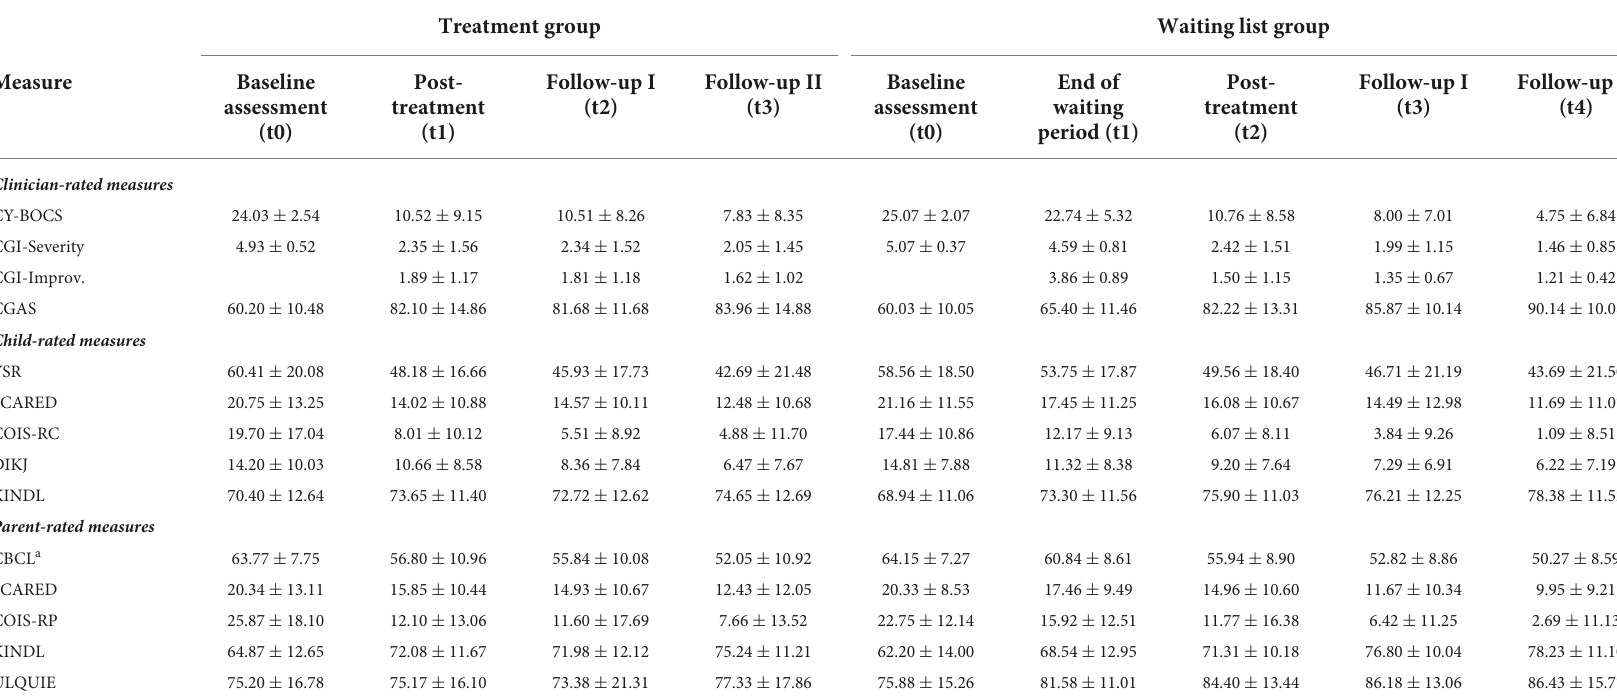
Unadjusted mean ± standard deviation